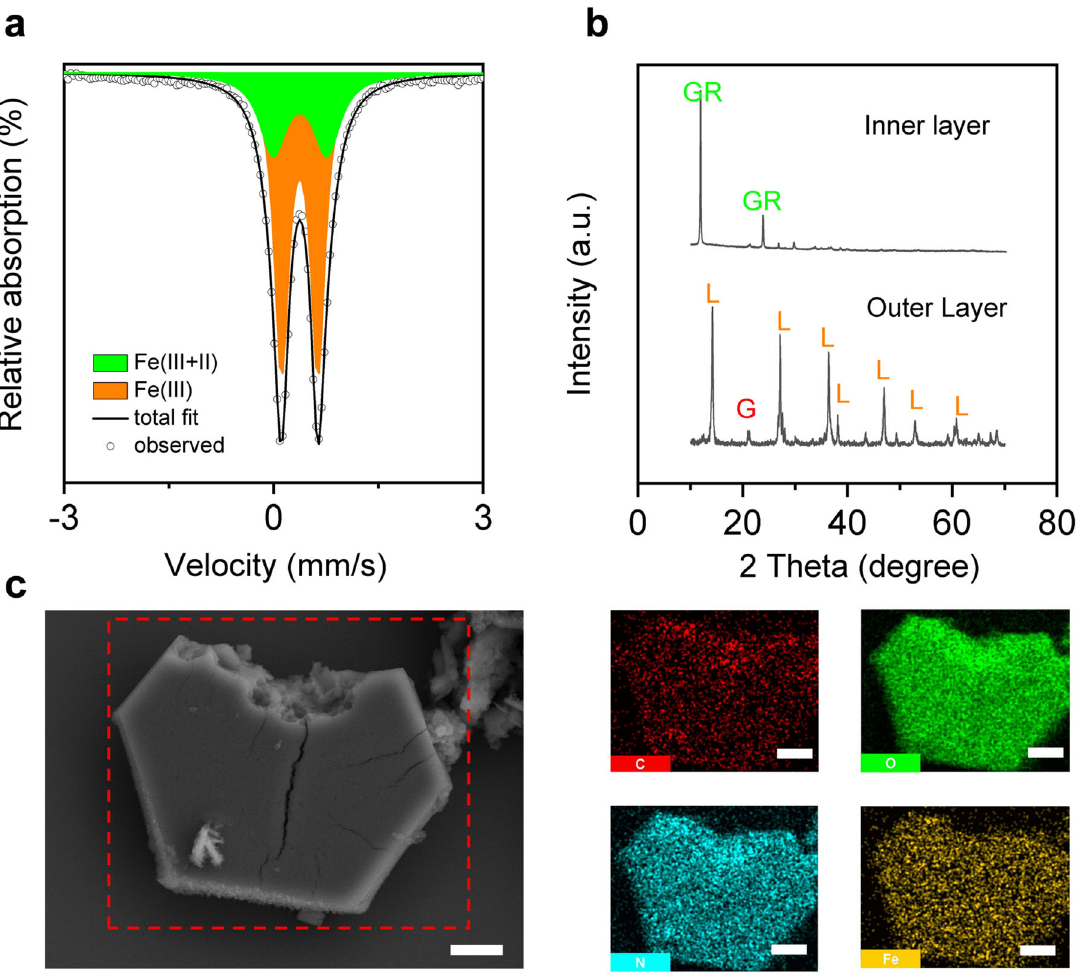
Fig. 3 Iron oxidation state identi fi cation in the microstructure on iron rod in Fe-sediment system. a Mössbauer spectrum of surface iron oxides on the iron rod measured at room temperature (293 K) and fi tted with the hopping relaxation model. Fe(III) (orange, 66.5%) and Fe(III)/ Fe(II) (green, 33.5%) doublets are shown, and the sum of modeled components are shown as the solid black line. b X-ray diffraction patterns of iron oxide inner and outer layers. (G-goethite, L-lepidocrocite and GR-green rust). c Scanning electron microscope images and energy dispersive X-ray spectroscopy analysis of microbial corrosion on a green rust crystal. (C, red; O, green; N, blue; Fe, yellow). Scale bars, 2